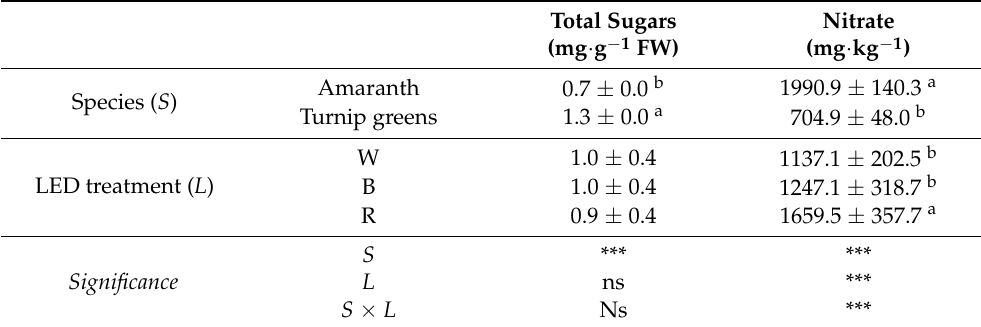
Values (mean ± se ) within each column, followed by the same letter, do not significantly differ at p ≤ 0.05